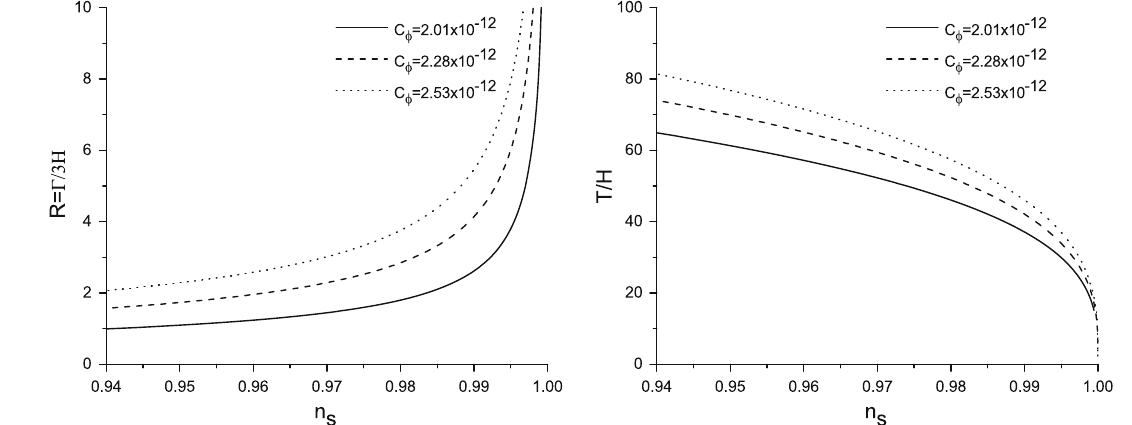
lines correspond to the pairs of values ( α = 1.5, V 0 = 1.07 × 10 − 12 ), ( α = 1.95 and V 0 = 1.09 × 10 − 12 ), and ( α = 2.4, V 0 = 1.13 × 10 − 12 ), respectively. In these plots we have fixed the values C γ = 70 and M p =